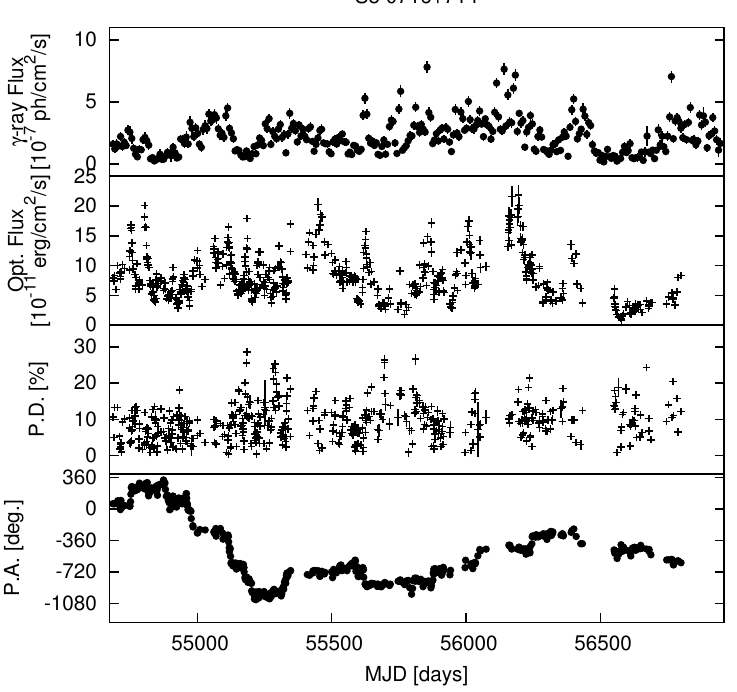
Figure 1. Temporal variability of gamma-ray flux, optical flux, polarization degree (P.D.), and polarization angle (P.A.) for the source S5 0716 + 714. This figure is modified from